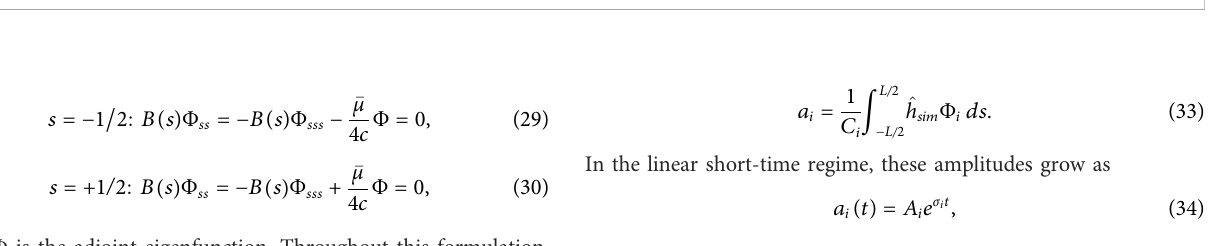
FIGURE 6 Comparison of the fi rst and third mode shapes for each rigidity pro fi le at various (cid:2) μ values. (A) and (C) : The fi rst and third mode shapes at the onset of instability, respectively (see Table 2 for critical (cid:2) μ values). (B) and (D) :The fi rst and third mode shapes at fl ow strengths much larger than these critical values, at (cid:2) μ (cid:1) 18 , 000 and at (cid:2) μ (cid:1) 30 , 000 respectively. All mode shapes are normalized to a max amplitude of